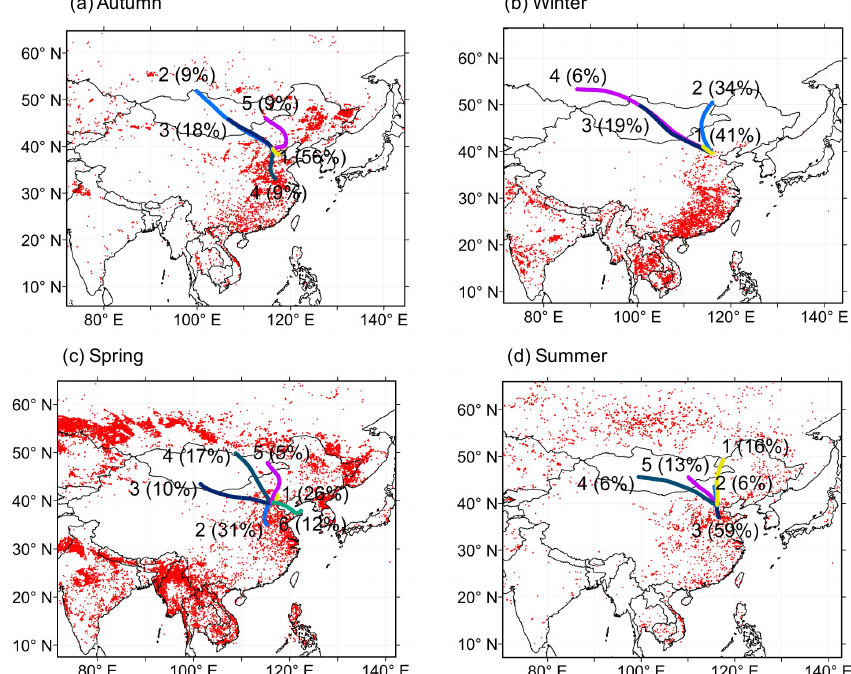
Figure 1. Fire spots with typical 5-day air mass backward trajectories (mean clusters) arriving at Beijing for each sampling season. The fire spot data were obtained from the MODIS fire spot website (https://earthdata.nasa.gov/earth-observation-data/near-real-time/firms). The air mass trajectories were drawn using the data obtained by the HYSPLIT4 model from the NOAA ARL website (http://ready.arl.noaa.gov/ HYSPLIT.php). The numbers in each panel imply the percentages of hourly trajectories in the sampling season with air mass origins. The arrival height of the air mass backward trajectories was 500m above sea level.